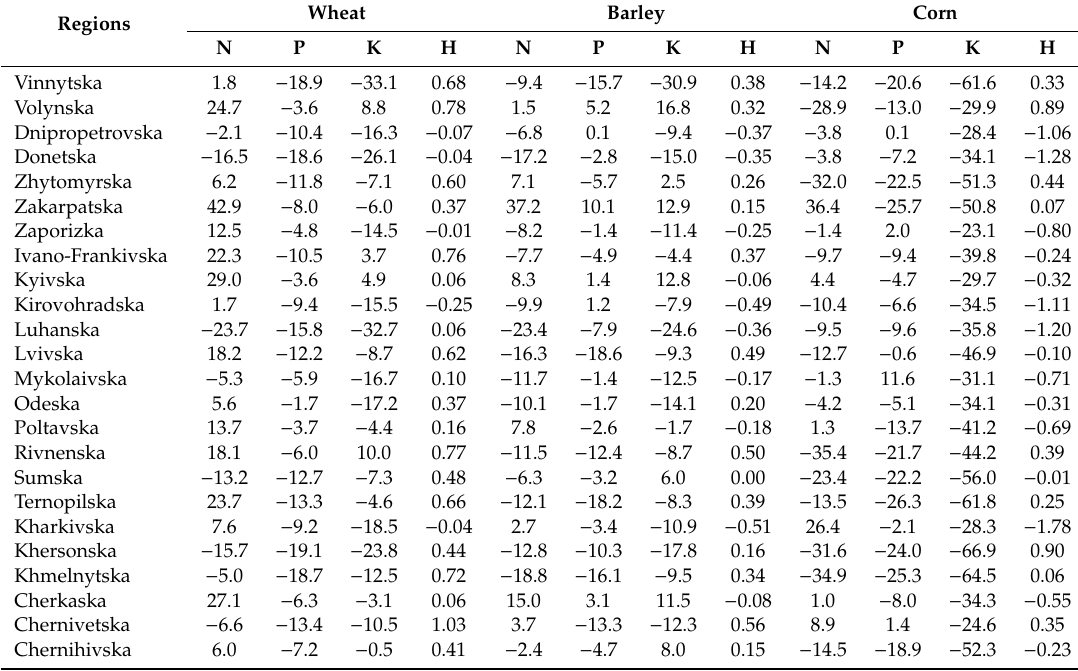
Table 4. Soil nutrient balance for the production of cereals in Ukraine by region (calculated for 2017). Wheat Regions